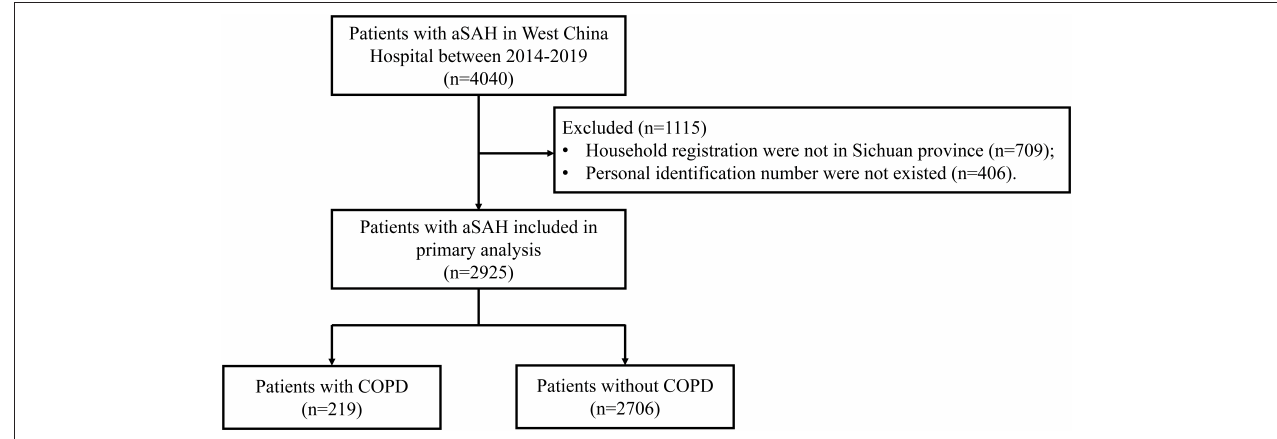
FIGURE 1 | Flow chart of